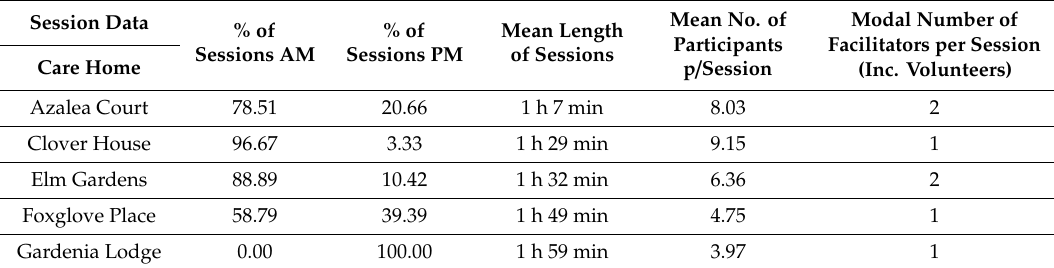
Table 4. NCI-UK sessions as enacted by participating care